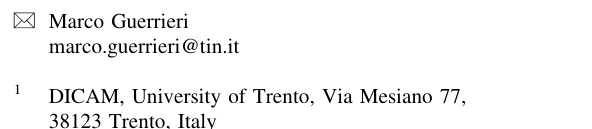
The original article can be found online at https://doi.org/10.1007/